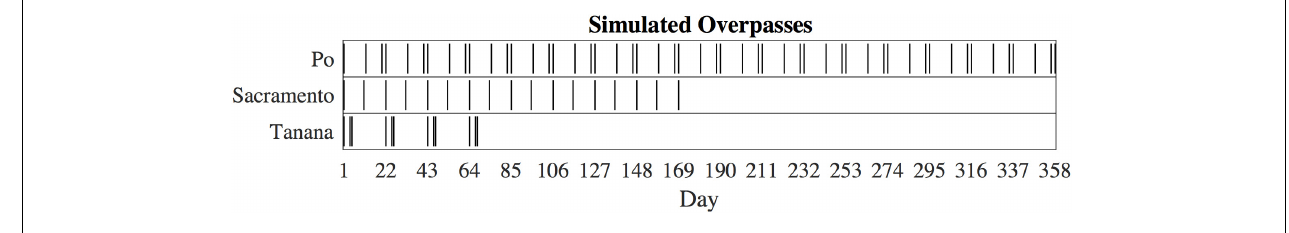
FIGURE 2 | Timing of the simulated overpasses for all three rivers. The observations have been aligned such that the first observation of each river is day